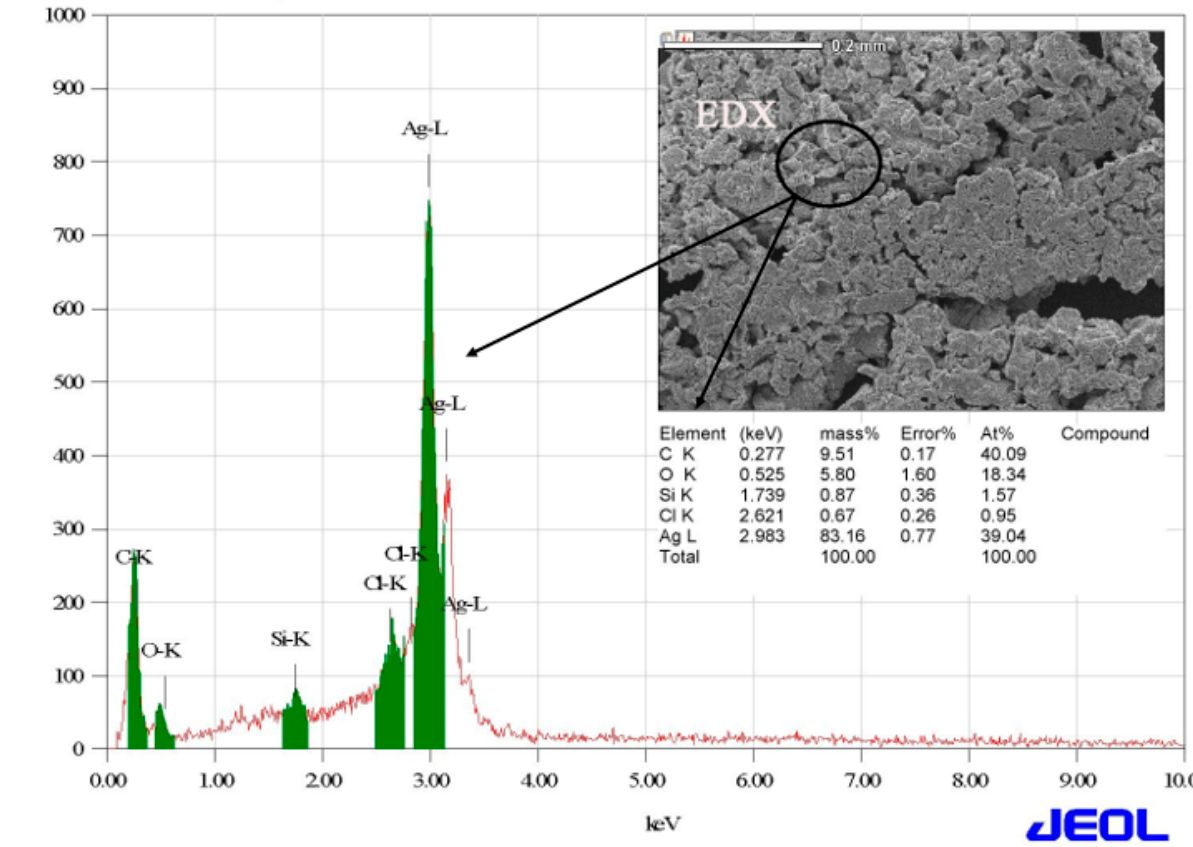
Figure 6. EDX analysis and SEM micrograph of the biosynthesized silver nanomaterials formulated using S. officinalis extract.